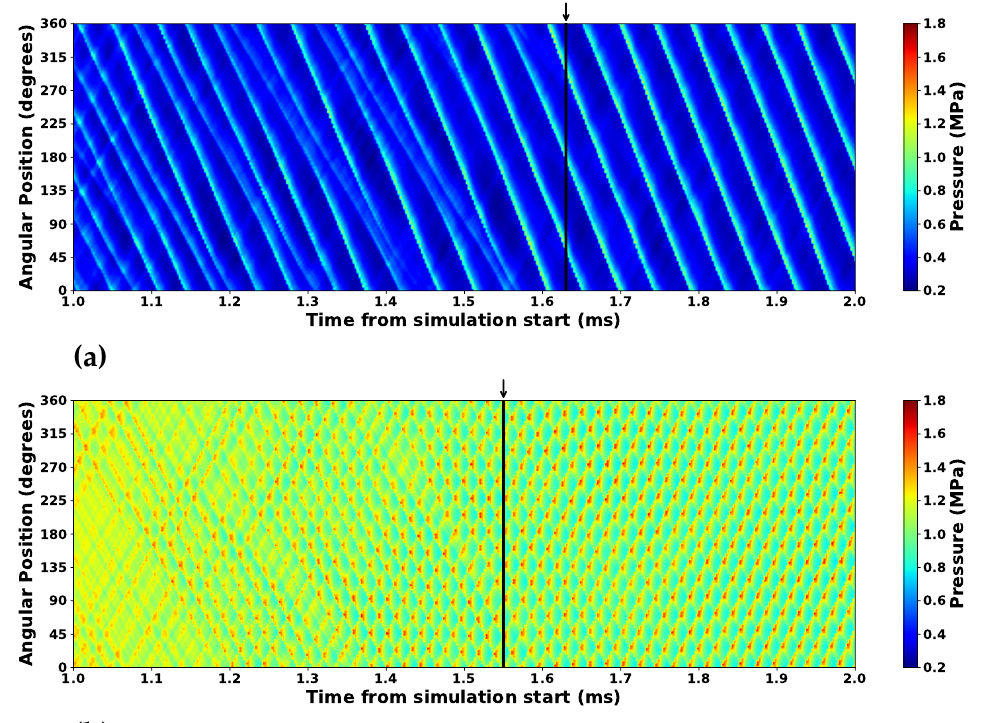
Figure 23. Detonation-region pressures for LES of ( a ) an unconstricted engine and ( b ) an engine with a nozzle constriction ( (cid:101) c = 2.40); both engines operate at ˙ m = 0.27 kg/s and φ = 1.1. The time window demonstrates the transition to a steady operation condition, with arrows and vertical lines indicating when the engine is considered to have reached a steady operating mode: t = 1.63 ms for the straight chamber geometry, and t = 1.55 ms for the constricted